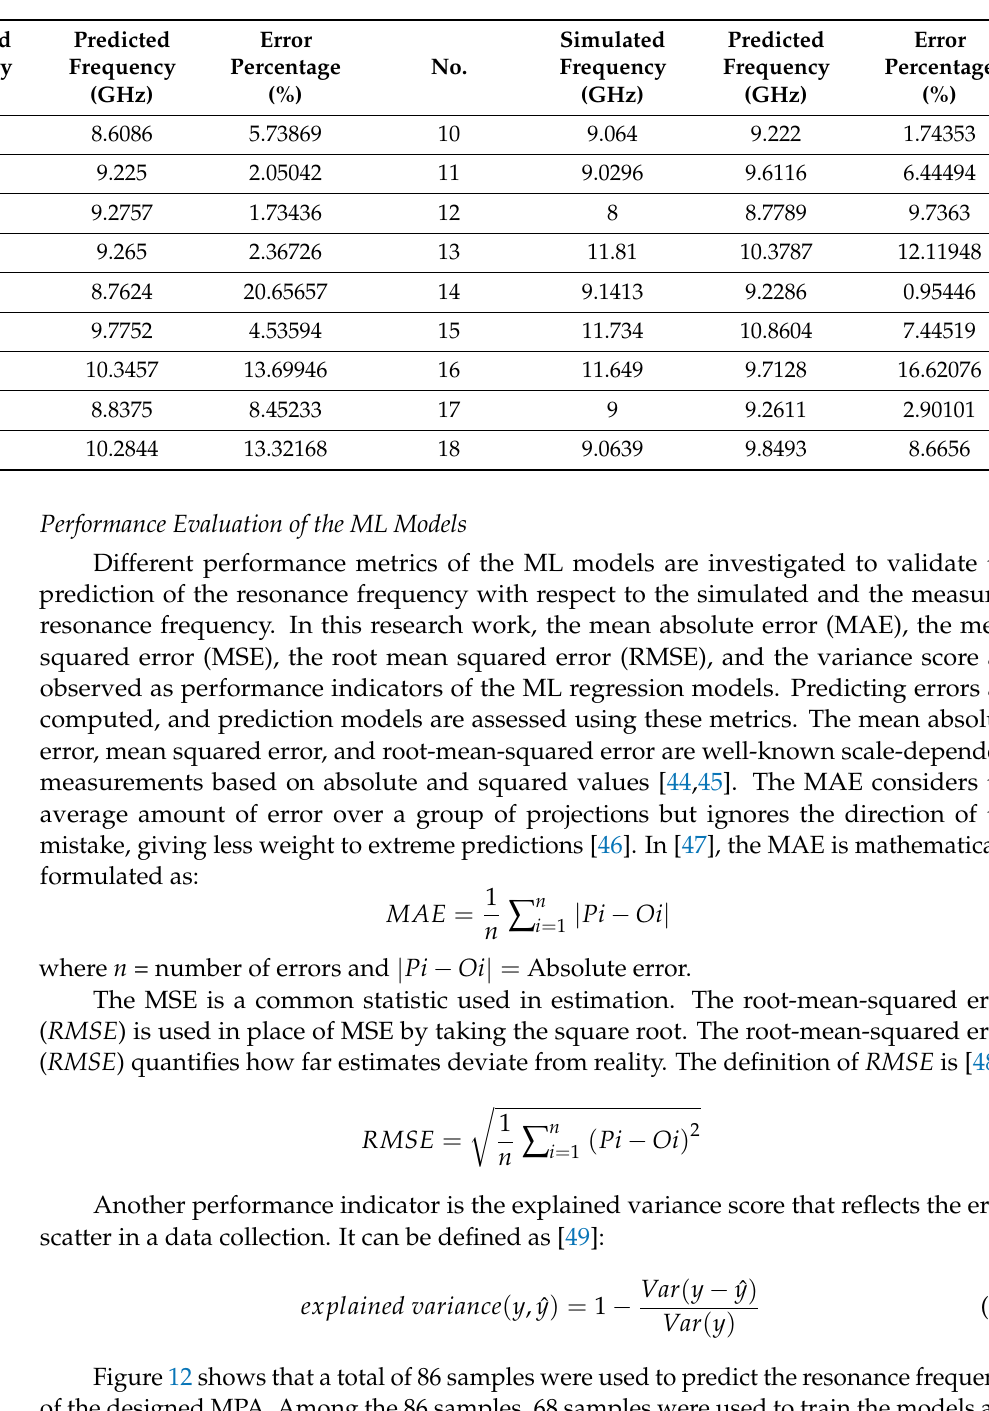
Table 4. Simulated and predicted resonant frequency comparison of the test set using